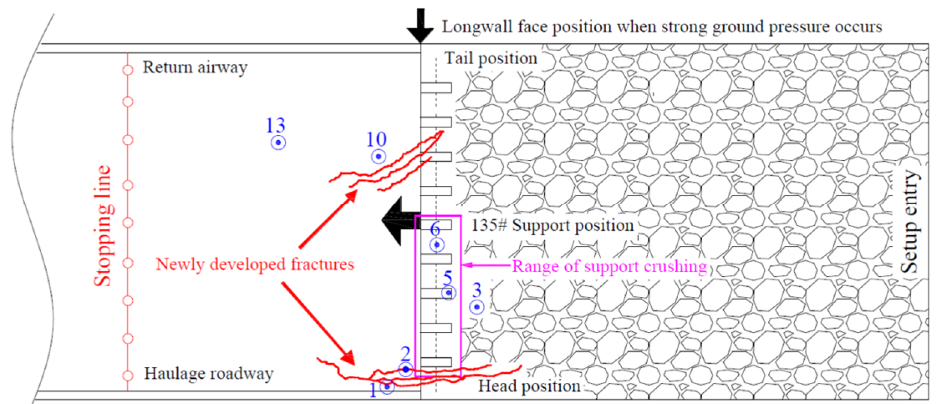
Figure 1. Plan view of the position of the newly developed fractures and the range of longwall face support crushing.